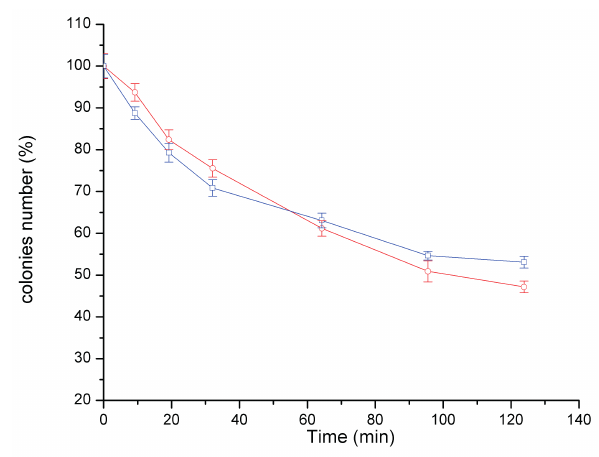
Figure 8: Evolution as a function of time of number of E coli colonies survived in culture media in the presence of reused LDH-biocide -NAD (–□–) and ZnAl- CO -PIP (–○–). ZnAl- CO 3 3